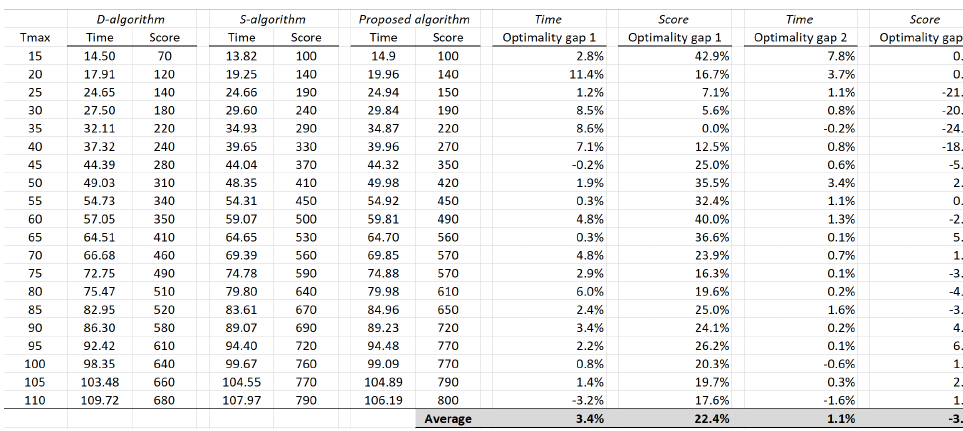
Figure 9. Algorithms comparison using data set of problem